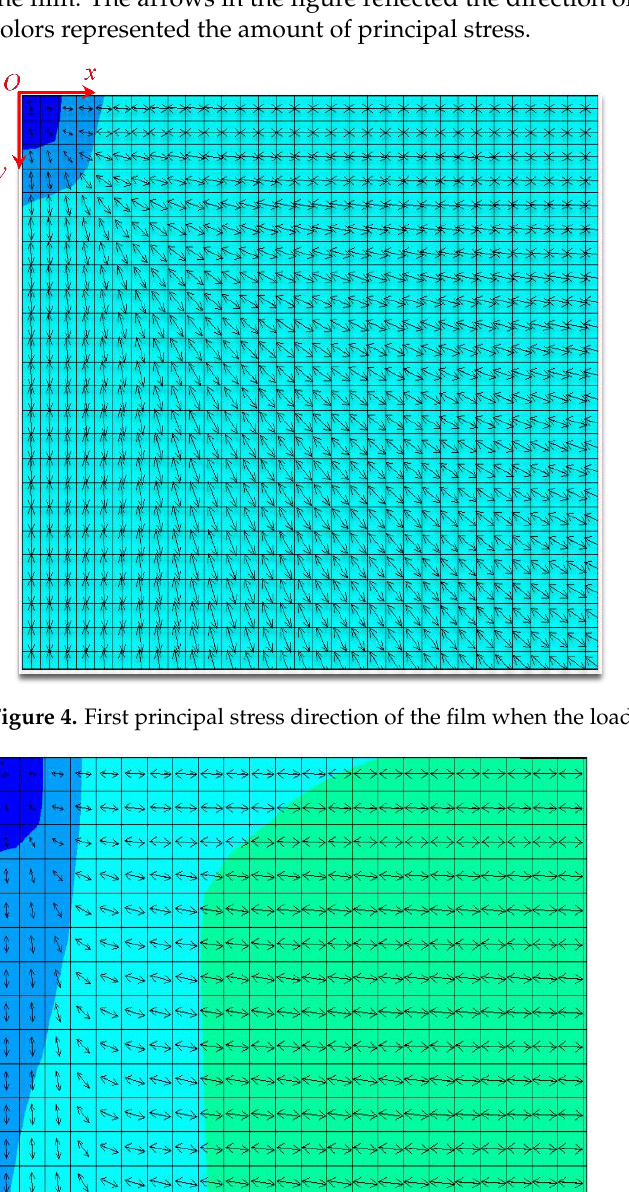
Figure 3. Finite element model diagram: ( a ) overall model and ( b ) local detail model.